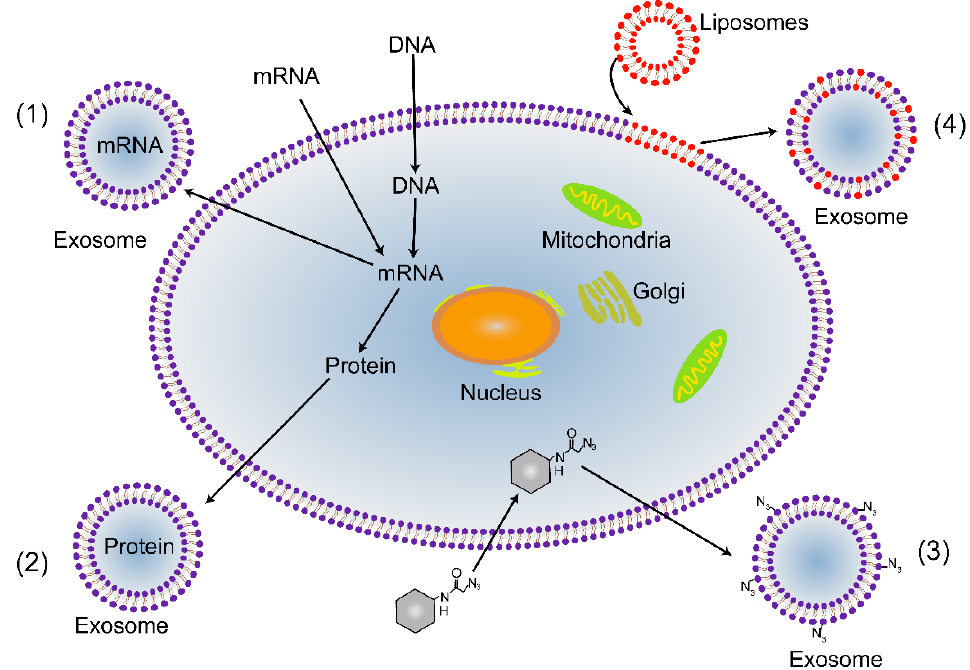
Figure 3. Strategies for re-engineering placenta-targeted exosomes. (1) Genetic engineering can be used to introduce mRNA and DNA into trophoblasts. It can be incorporated into exosomes to promote gene expression or regulate transcription in recipient trophoblasts. (2) Transgenic proteins can be packaged into exosomes, for example, as targeting moieties and fluorescent reporters. (3)